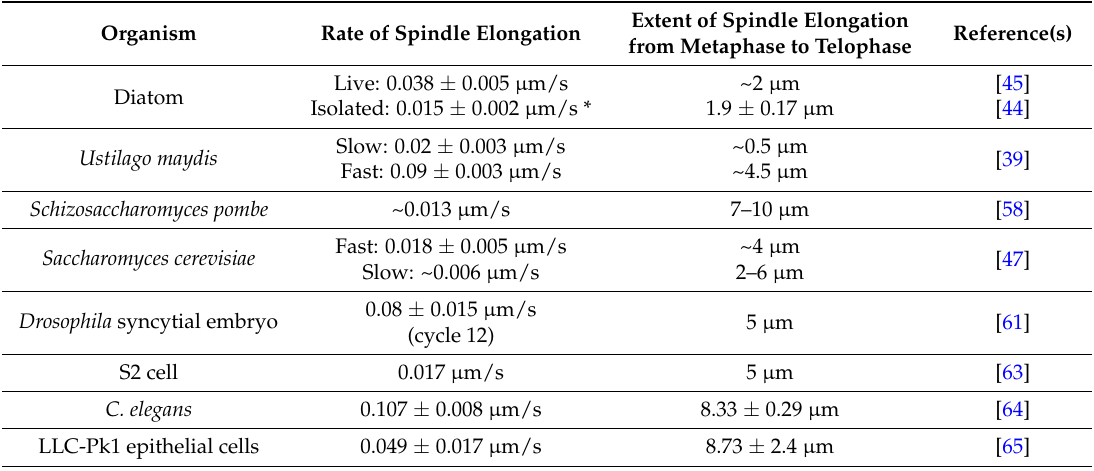
Table 1. Rates and extent of spindle length changes during anaphase